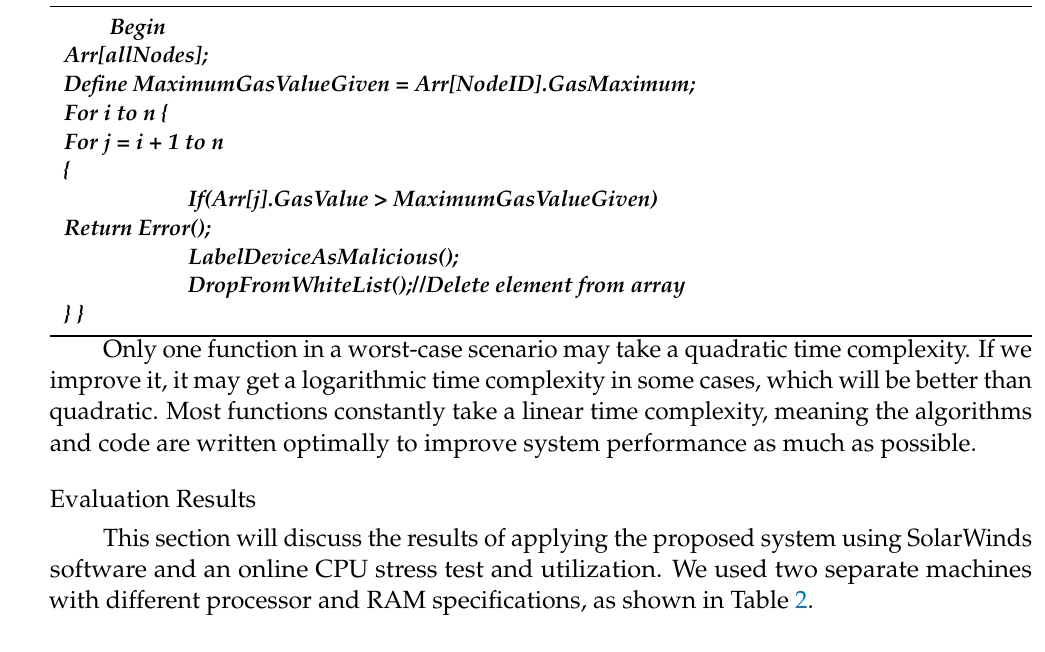
Table 2. Machine Specification.